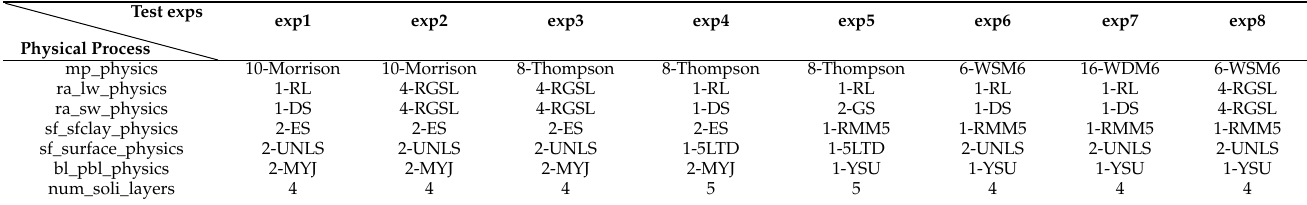
Table 4. The settings of eight sensitivity